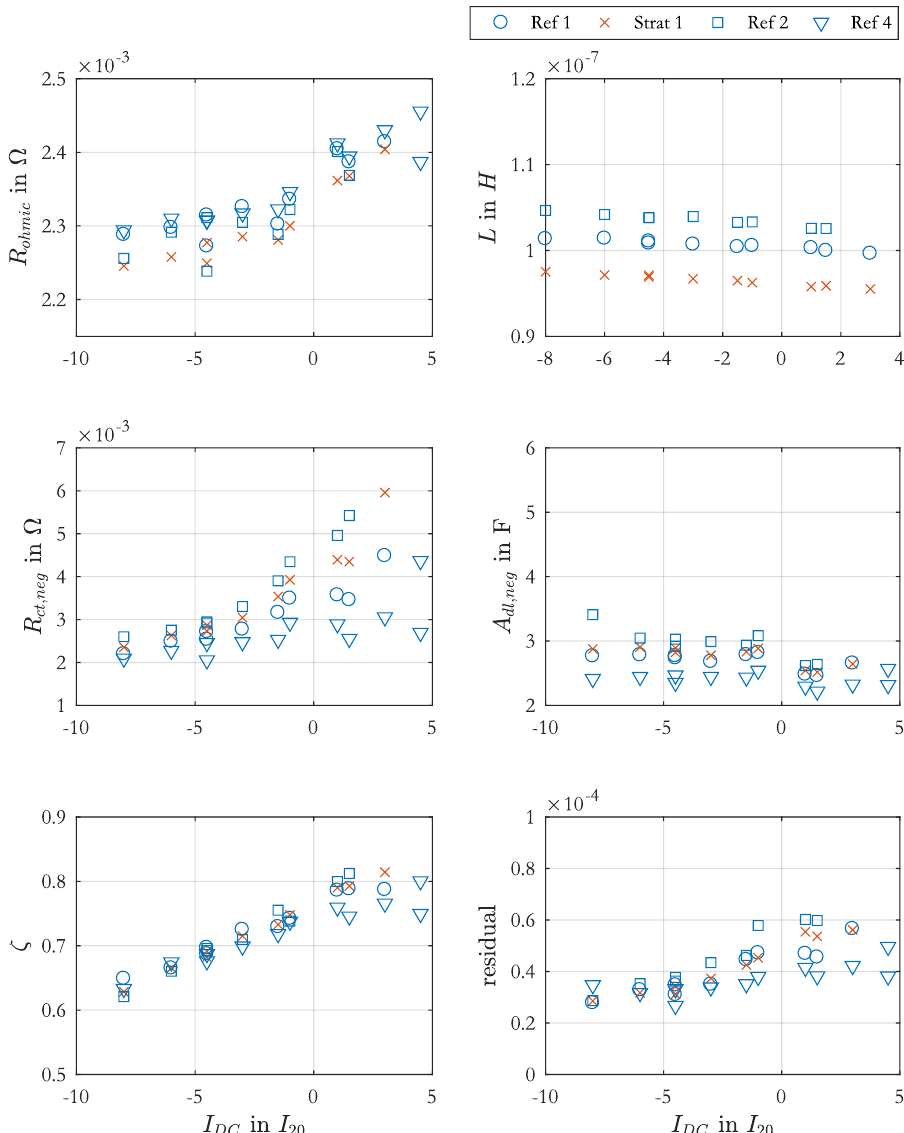
Figure 6. EEC element values together with the residual from fitting of the impedance spectra in EIS sets Ref. 1 , Strat. 1 , Ref. 2 and Ref. 4 . Positive currents are charging currents and negative currents denote the discharging